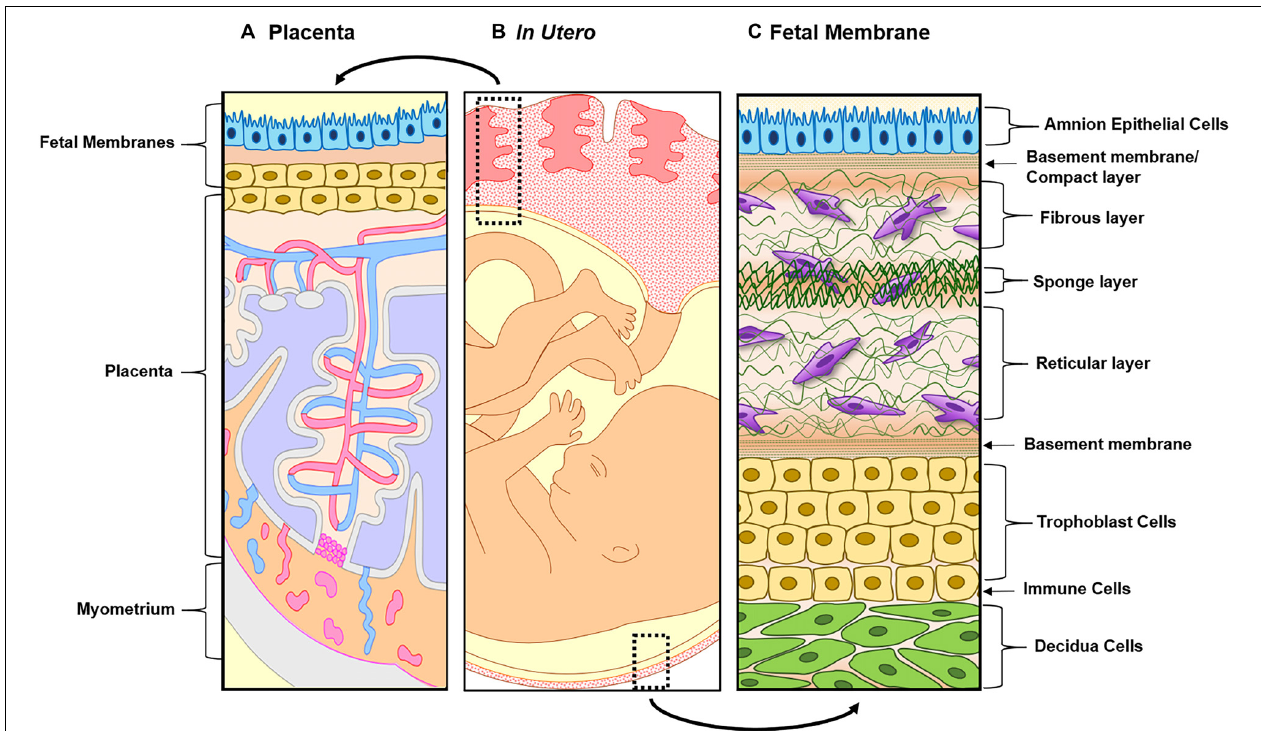
FIGURE 2 | Illustration of both feto-maternal interfaces in utero . (A) The left side represents the placenta, the site of nutrients, oxygen, and waste exchange for the growing fetus. The placenta is attached to the maternal side by the decidua basalis next to myometrium (gray) and the fetal side through the fetal membranes (amnion in blue and chorion in yellow). This image highlights the tertiary chorionic villi and arteries (red) and veins (blue), respectively. (B) Overview of the two feto-maternal interfaces in relation to the fetus. The top box outlines the cross-section of the placenta and the bottom box outlines the cross-section of the fetal membrane. (C) The description starts from the innermost layer (amnion) and ends at the maternal decidua. Amnion epithelial cells (blue) are connected to the first layer of the ECM called the basement membrane/compact layer (green strips). The fibroblast (top), spongy (middle), and reticular layers (bottom) follow, containing amnion and chorion mesenchymal cells (purple). The chorion (yellow) is connected to the ECM through a basement membrane (green stripes and is made up of two types of cells: chorion laeve cells and chorion trophoblast cells. The chorion interfaces with the maternal decidua (green), connecting the fetal layers to the maternal compartments of the